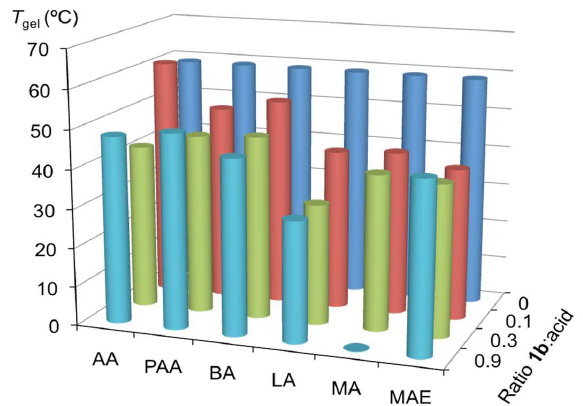
Figure 9. T gel of the gel made of 1b ( c = 7 g/L) in CHCl 3 and the effect caused by the incorporation of selected acids at different ratios (molar ratio 1b :acid = 0.1, 0.3, 0.9). Abbreviations: AA = acetic acid; PAA = phenylacetic acid; BA = benzoic acid; LA = lactic acid; MA = mandelic acid; MAE = mandelic acid methyl ester. The average values of at least two independent measurements are shown. Estimated error 2 °C.